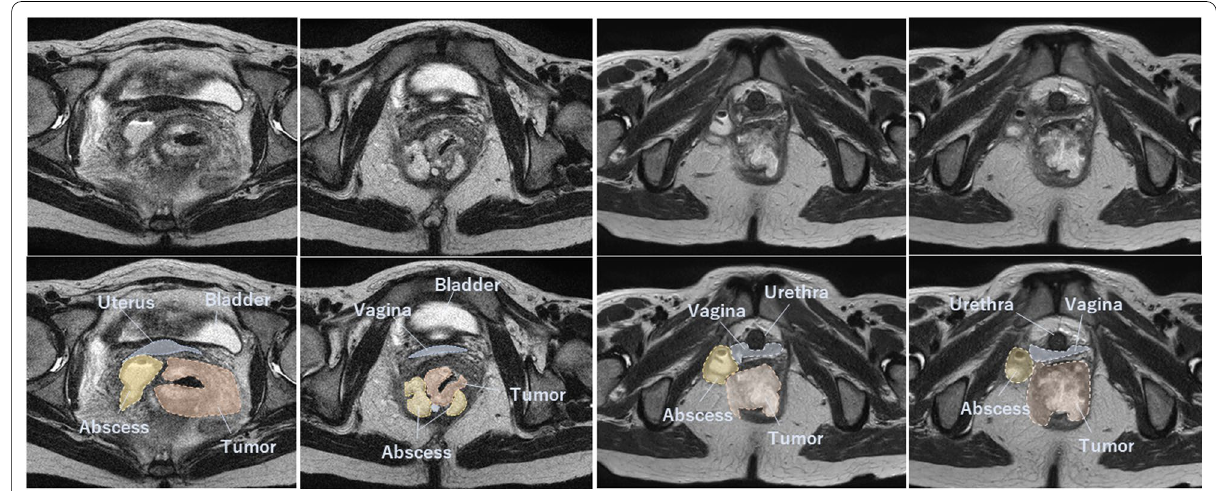
Fig. 1 Preoperative axial pelvic magnetic resonance scans. Rb-p rectal tumor with abscess extending extensively into the pelvis and to the right side of the vagina and urethra. Blue area, uterus and vagina. Orange area, tumor. Yellow area,